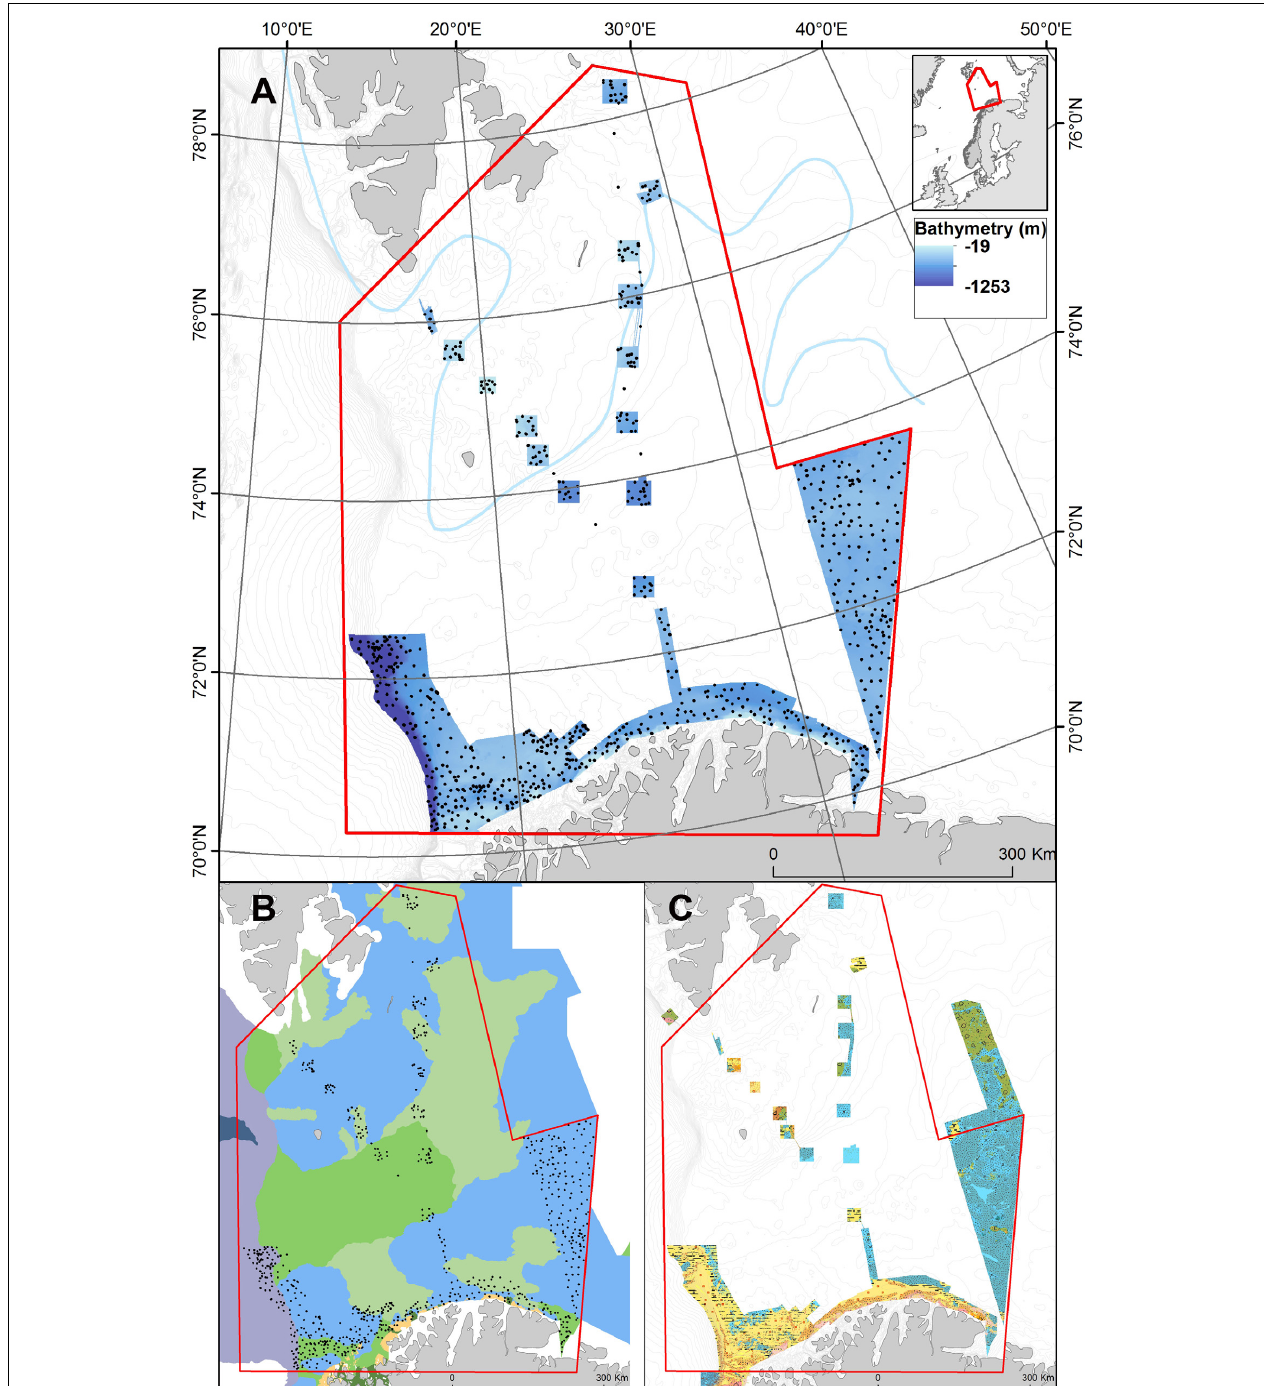
FIGURE 1 | (A) Map of the study area in the Barents Sea. The extent of the study area is indicated in red and MAREANO video stations used in this study area shown as black dots over color shaded bathymetry from Kartverket https://mareano.no/en/maps-and-data/marine-geospatial-data. The approximate location of the polar front is indicated with a line. (B) A MAREANO landscape map (broad-scale geomorphology) showing how the area is dominated by continental shelf plain (blue), marine valleys (green), and shallow marine valleys (light green) with areas near the coast comprising strandflat (orange) while deeper areas to the west are classified as smooth continental slope (purple). Full symbology is available at https://www.ngu.no/Mareano/Landscape.html. Landscape mapping procedures are based on Elvenes (2013). (C) A MAREANO sediment map showing how the southwestern part of the study area is dominated by sandy and gravelly sediments (yellow, orange) while eastern areas are dominated by muddy sediments (blue). Full symbology available at https://www.ngu.no/Mareano/Grainsize.html.